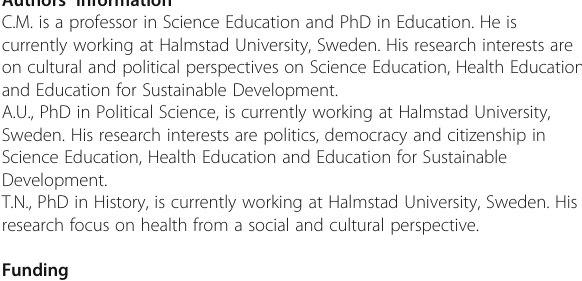
Table 1. List of teaching material analysed (see manuscript page 11 –